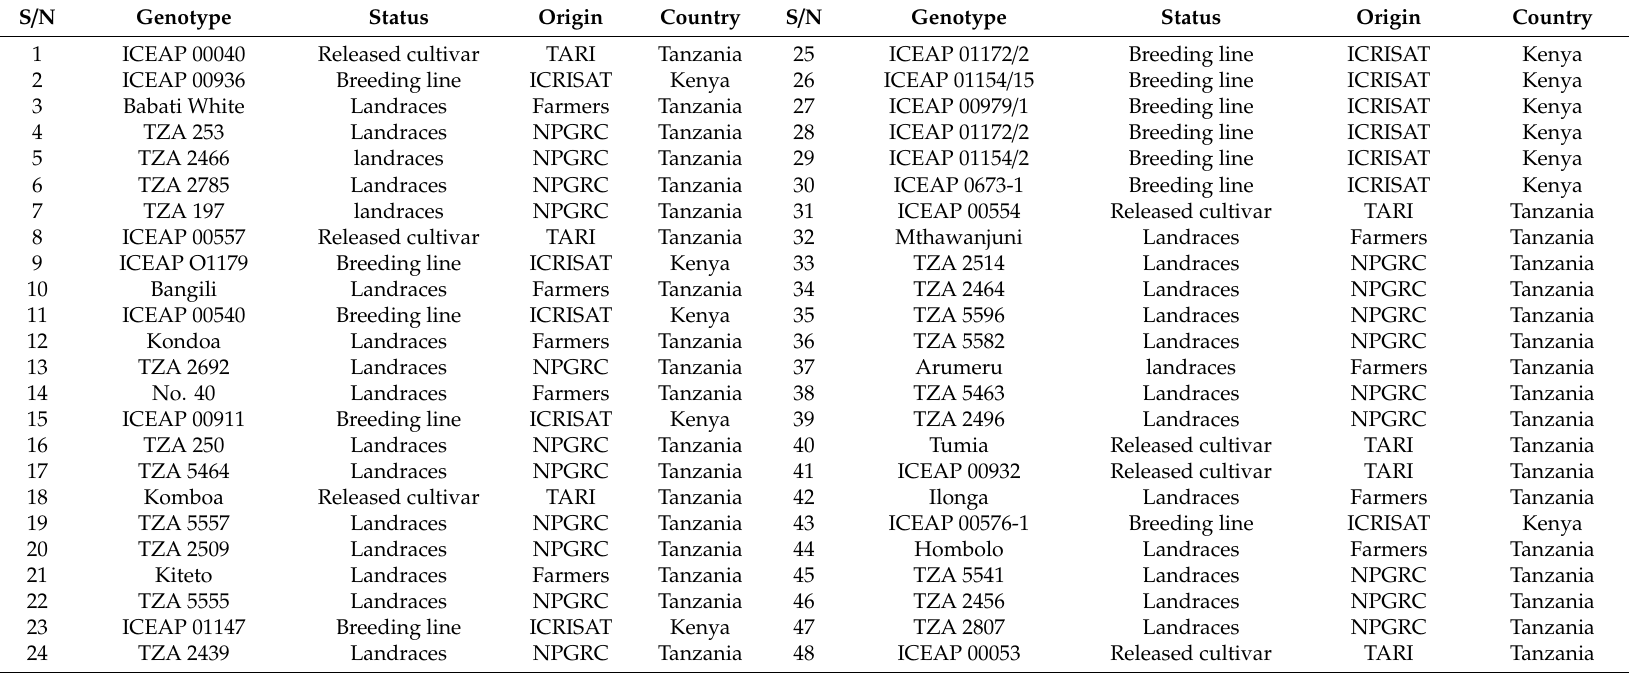
Table 1. List of the pigeonpea genotypes evaluated in this study, their place of collection and country of